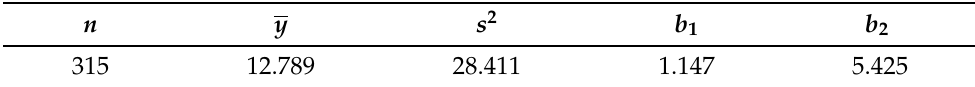
Table 3. Fiber: Descriptive statistics.